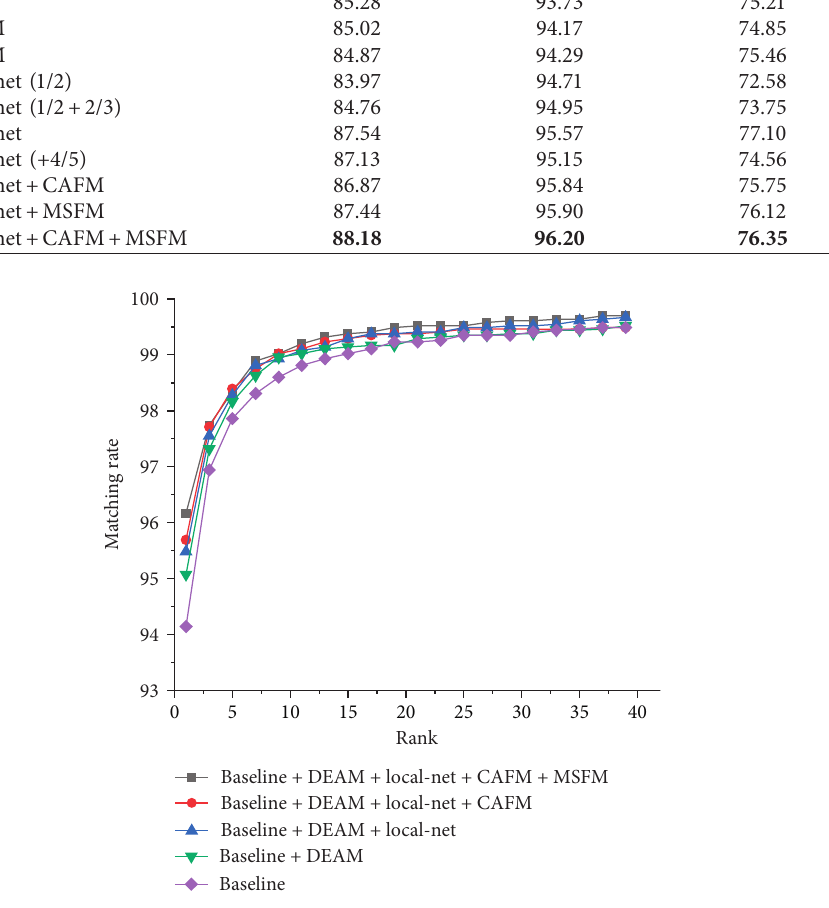
Figure 7: CMC curves of five networks on the Market-1501 dataset. Table 2: Experimental results of this model compared with other Re-ID